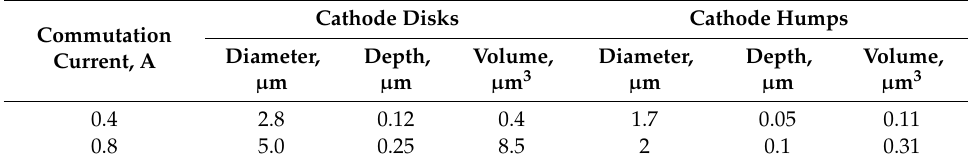
Table 2. Geometrical characteristics of the anode craters versus the commutation current.